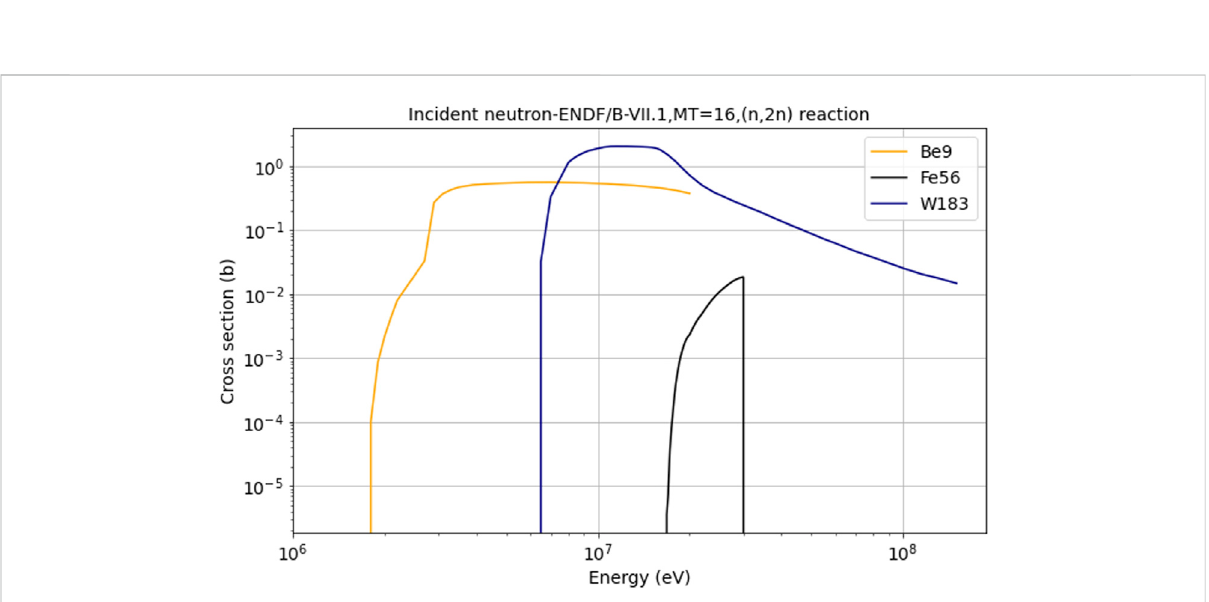
FIGURE 3 (n, 2n) reaction, MT = 16 cross-section distributions of 9 Be, 56 Fe, 183